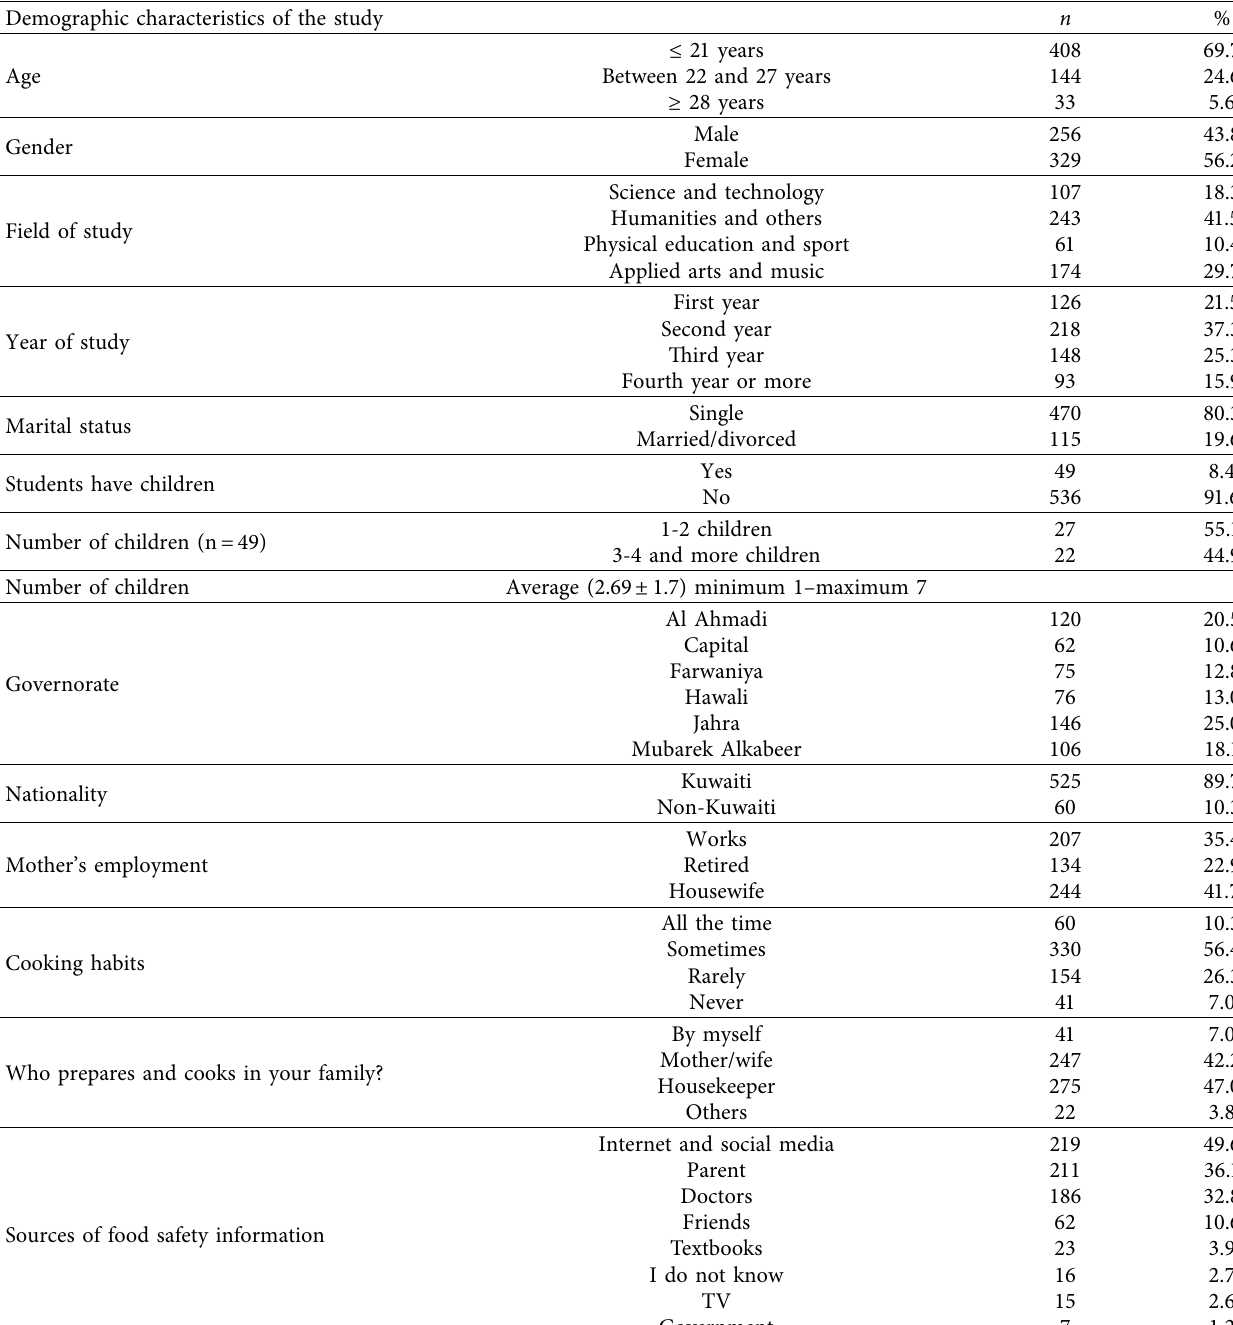
Table 1: Demographic characteristics of the study ( n �